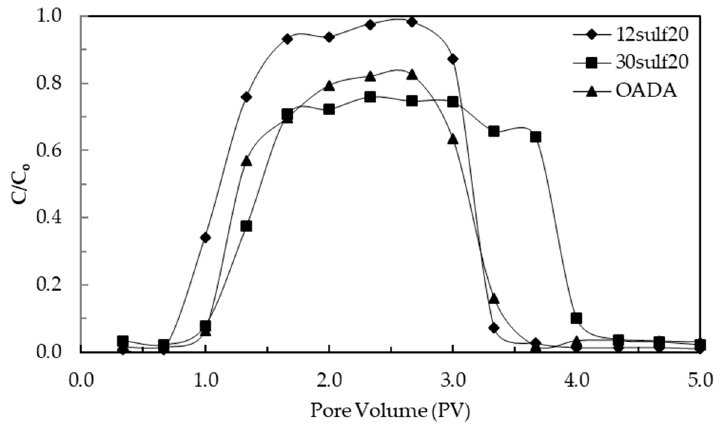
Figure 15. Breakthrough curves for suspensions of 12sulf20 SPSNP and 30sulf20 SPSNP and OADA solution (0.2 m %/ v %).